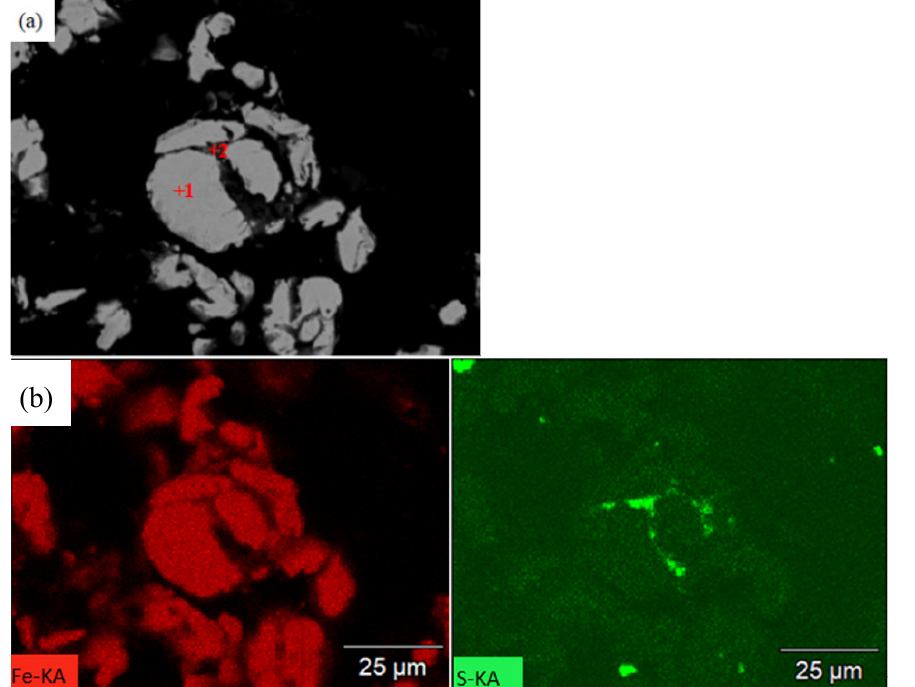
Figure 12. SEM-EDS images and elemental surface scanning images of reduced iron products without CaO. ( a ) SEM-EDS images, “+” refer to analyzed point by EDS, numbers refer to composition data in Table 7; ( b ) elemental surface scanning images of ( a ). Table 7. Chemical composition of points indicated in Figure 12 (wt%).